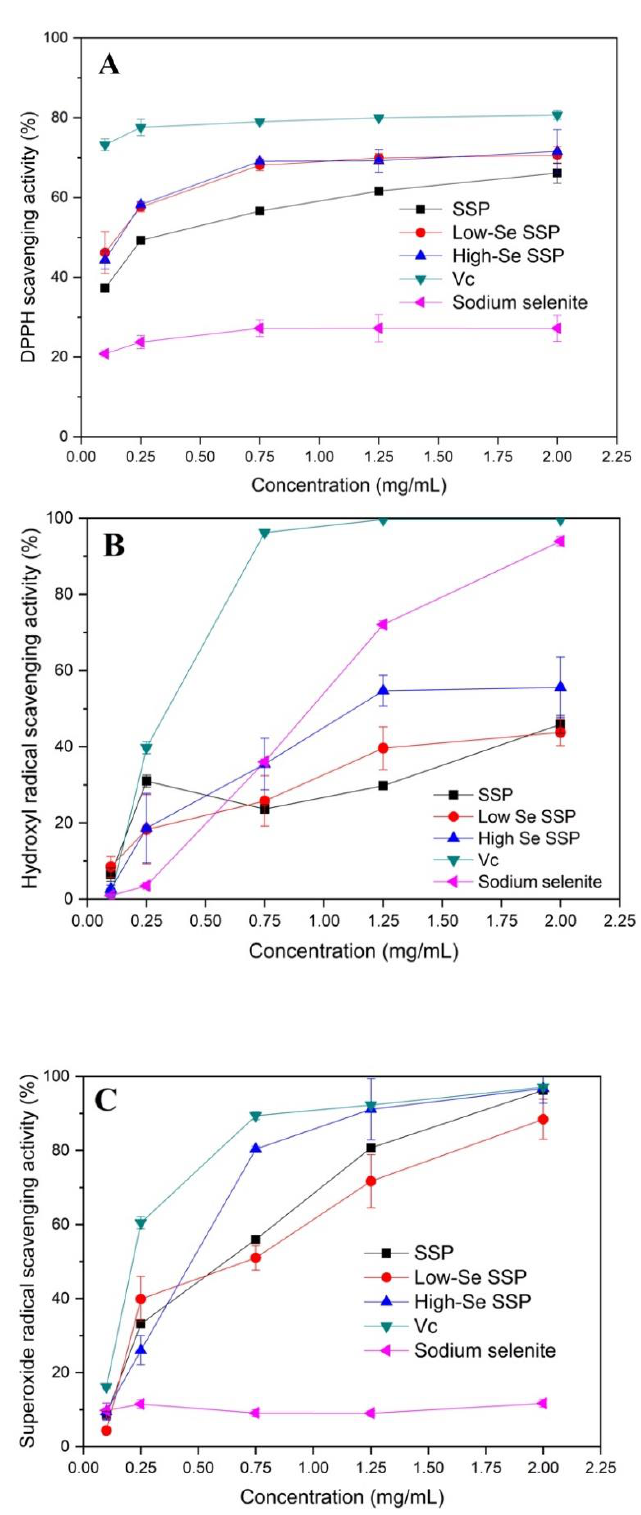
Figure 4. Scavenging activities of SSP, low-Se SSP, high-Se SSP, Vc (positive control)and sodium selenite (inorganic Se) at various concentrations against 1,1-diphenyl-2-picrylhydrazyl radicals ( A ), hydroxyl radicals ( B ) and superoxide radicals ( C ). Values are means ± SDs ( n = 3).